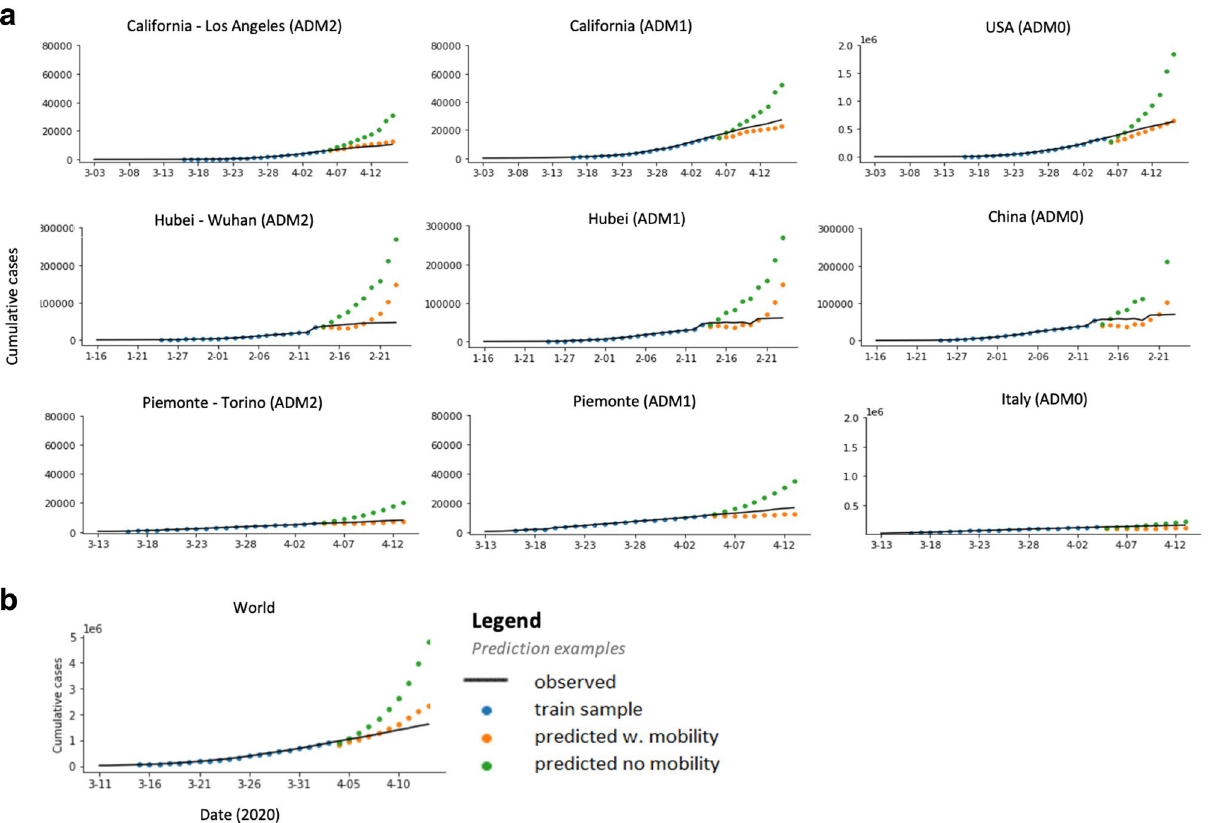
Figure 3. Short term prediction of COVID-19 cases. Solid line is the recorded number of COVID-19 infections, markers show data in our training sample (blue) and our predictions estimated using mobility measures (orange) versus a model without mobility (green). Model with no mobility measures consistently over- predict the number of infections and drift away quickly from the observed data. ( a ) This pattern is confirmed when aggregating locally estimated predictions (left) at the state (middle) and country (right) level. ( b ) Similarly, predictions obtained from country level estimates are significantly more accurate when a measure of mobility is